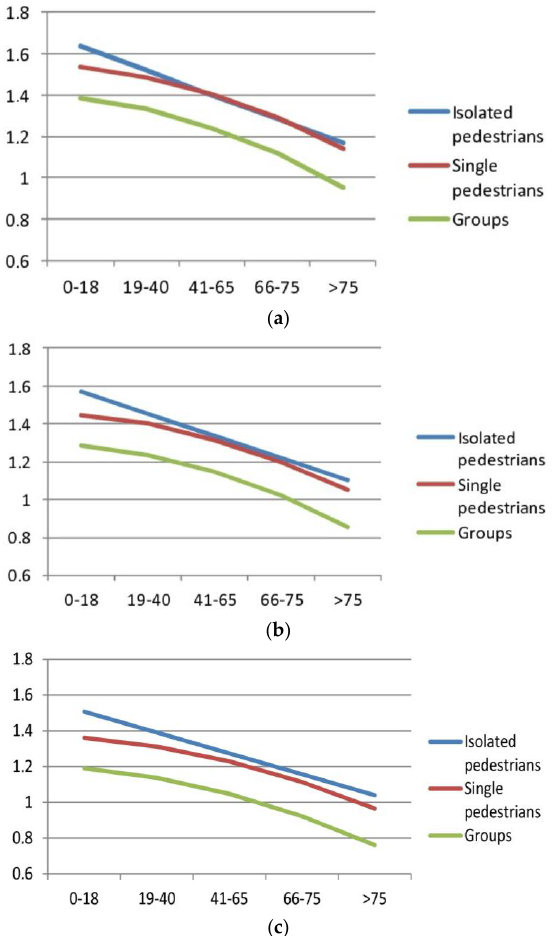
Figure 11. Models A, B and C. Comparison between users type behavior: ( a ) facing type: blind; ( b ) facing type: accesses; and ( c ) facing type: shop windows.